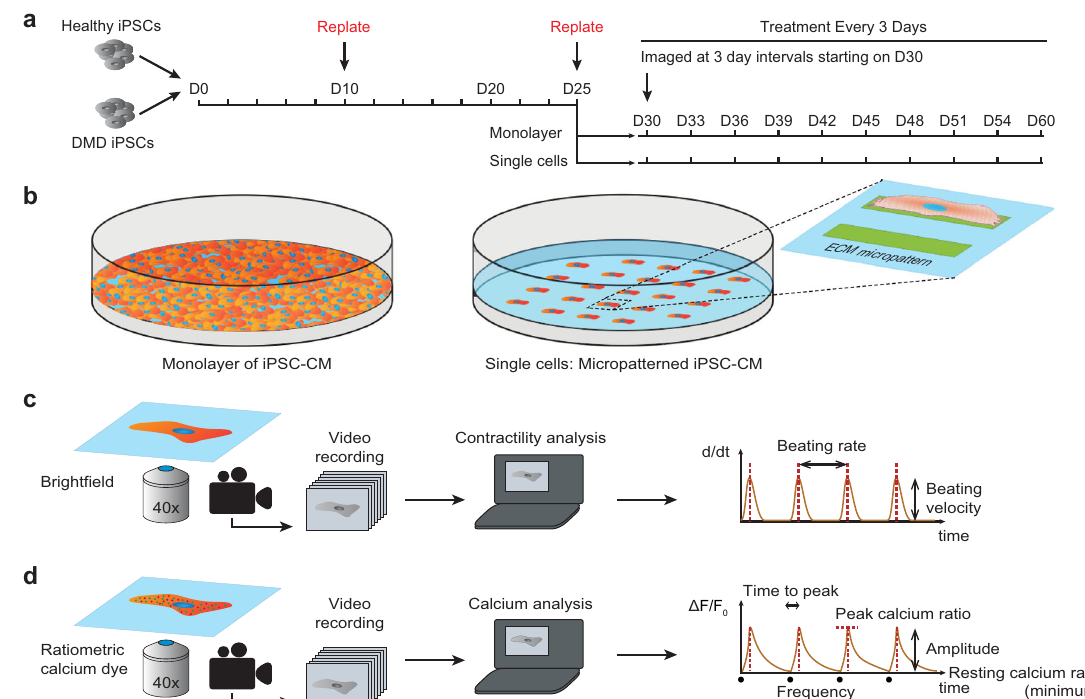
Fig. 1 Experimental design for chronic 4-hydroxytamoxifen treatment. a Cells are replated on day 10 (D10), then seeded onto our bioengineered platform on day 25 (D25). Cells are imaged and treated every 3 days from day 30 (D30). b Schematic of iPSC-CMs cultured in a monolayer (left) and as single cells on extracellular matrix (ECM) micropatterns with a length to width aspect ratio of 7:1 (right). c Motion- tracking analysis was used to measure the beating rate and beating velocity of the iPSC-CM monolayers and single cells. Videos of contracting cardiomyocytes are recorded, and analysis is performed to calculate speed of contraction (d/d t ). The beating rate is de fi ned as the number of contraction cycles per unit of time. The beating velocity is de fi ned as the maximum contraction speed. d Ratiometric analysis of calcium fl ux in iPSC-CM single cells. Videos of contracting cardiomyocytes loaded with a ratiometric calcium dye are recorded, and analysis is performed to measure calcium bound dye and calcium-free dye relative to baseline ( Δ F / F 0 ). Time to peak is de fi ned as the time between the local minimum at the start of the peak and the next local maximum. Transient amplitude is de fi ned as the difference between the maximum Δ F/F 0 and the minimum Δ F/F 0 for each peak. Frequency is the number of calcium oscillations per second. The resting calcium ratio is the minimum Δ F/F 0 . Peak calcium ratio is the maximum Δ F/F 0